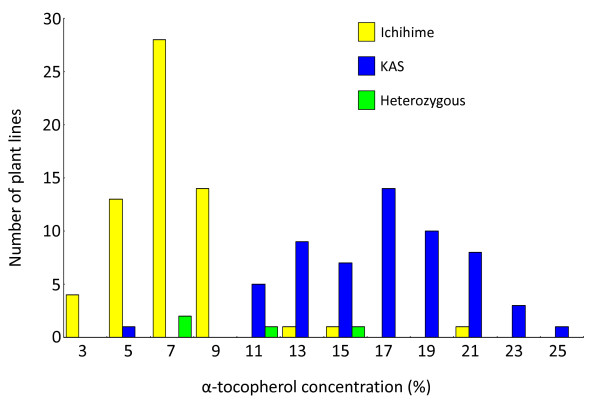
Frequency distribution of phenotypes and genotypes of marker closely linked for α-tocopherol concentration in F5 plant lines. Frequency distribution of α-tocopherol concentration and genotypes of the KSC138-17 marker in F5 plant lines. Yellow, blue, and green bars represent plant lines with Ichihime, KAS, and heterozygous genotypes, respectively.